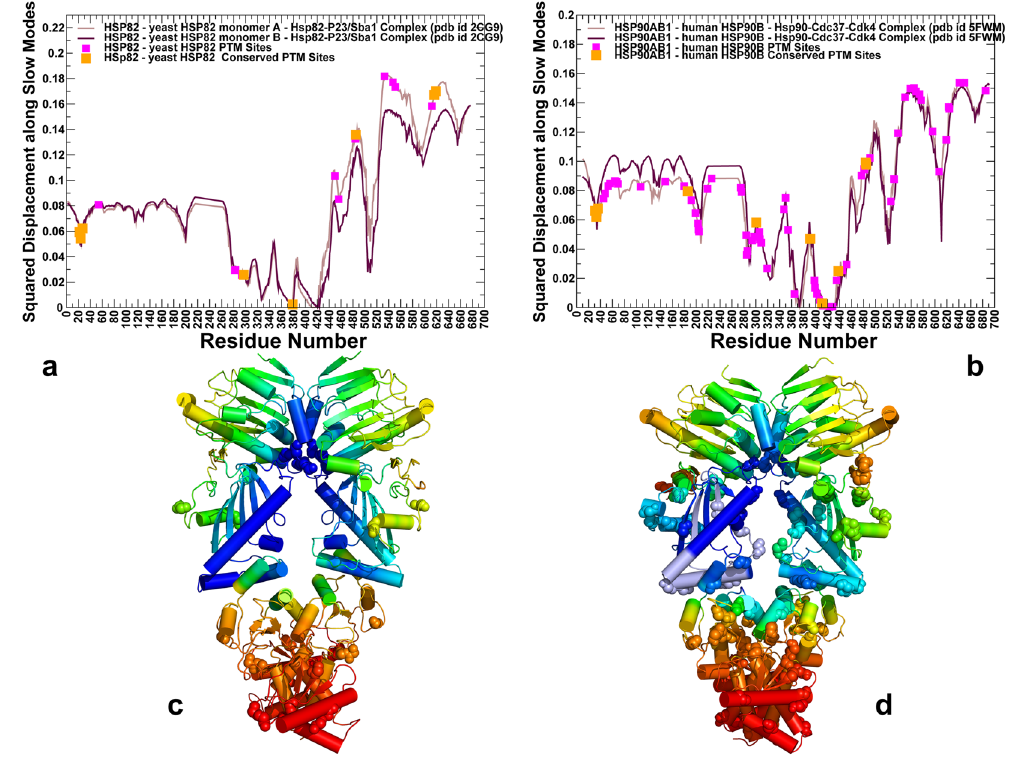
Figure 6. Functional Dynamics and Slow Mode Profiles of the yeast Hsp82 and human Hsp90 β Dimers. Functional dynamics profiles of the yeast Hsp82 ( a ) and human Hsp90 β ( b ) are represented as normalized square displacements of the protein residues averaged over the first three PCA modes. The residue-based slow mode profiles are shown for the monomer A (in light brown bars) and for the monomer B (in maroon bars). The PTM sites are mapped onto the slow modes profiles and depicted as filled magenta squares. The conserved PTM sites are annotated as filled orange squares. Structural mapping of the functional dynamics profiles driven by the slowest three PCA modes onto the crystal structure of ATP-bound Hsp82 dimer ( c ) and cryo-EM structure of the human Hsp90 β dimer from the complex with Cdc37-Cdk4 ( d ). The color gradient from blue to red indicates the decreasing structural stability (or increasing conformational mobility) of protein residues. The PTM sites are shown as spheres colored according to their mobility in the slow